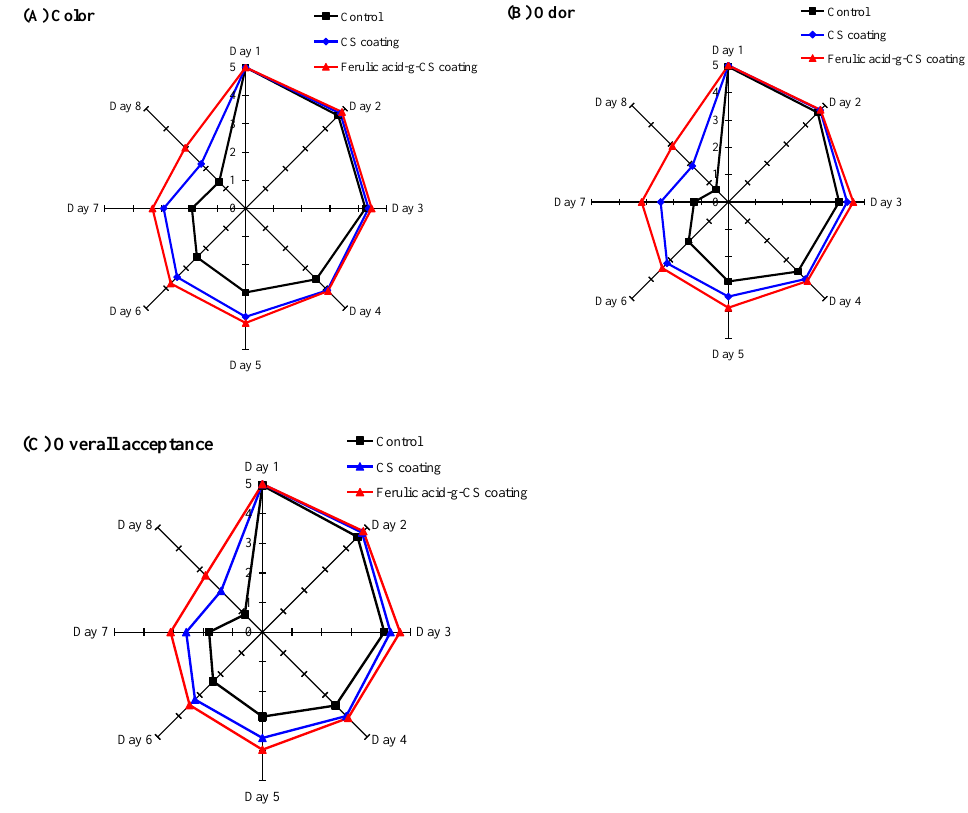
Figure 7. Changes in the sensory properties including color ( A ), odor ( B ), and over acceptance ( C ) of pork in the control group, CS coating group and ferulic acid-g-CS coating group at 4 °C for 8 days. Data are presented as means ± SD of triplicates.